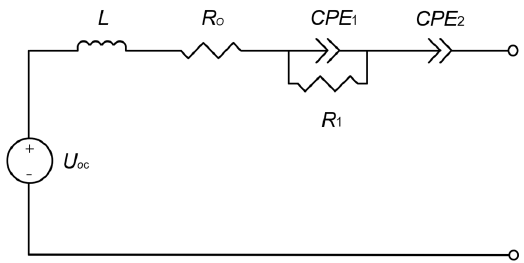
Figure 2. Equivalent circuit of the battery impedance model.